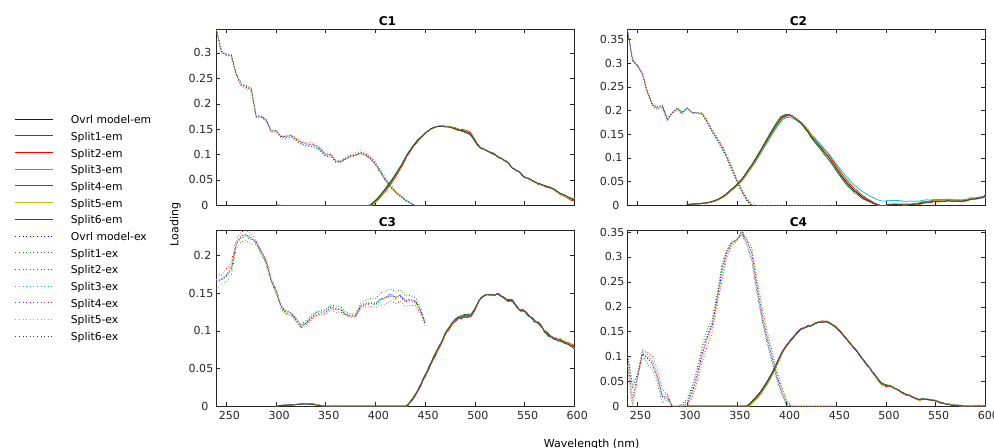
Figure B1. Split-half validation of the PARAFAC model. The models for six halves generated by the standard method described in Murphy et al. (2013) are shown. When the fits of the splits are similar to each other and the entire model, a high stability of the model and low randomness of the fluorophores is